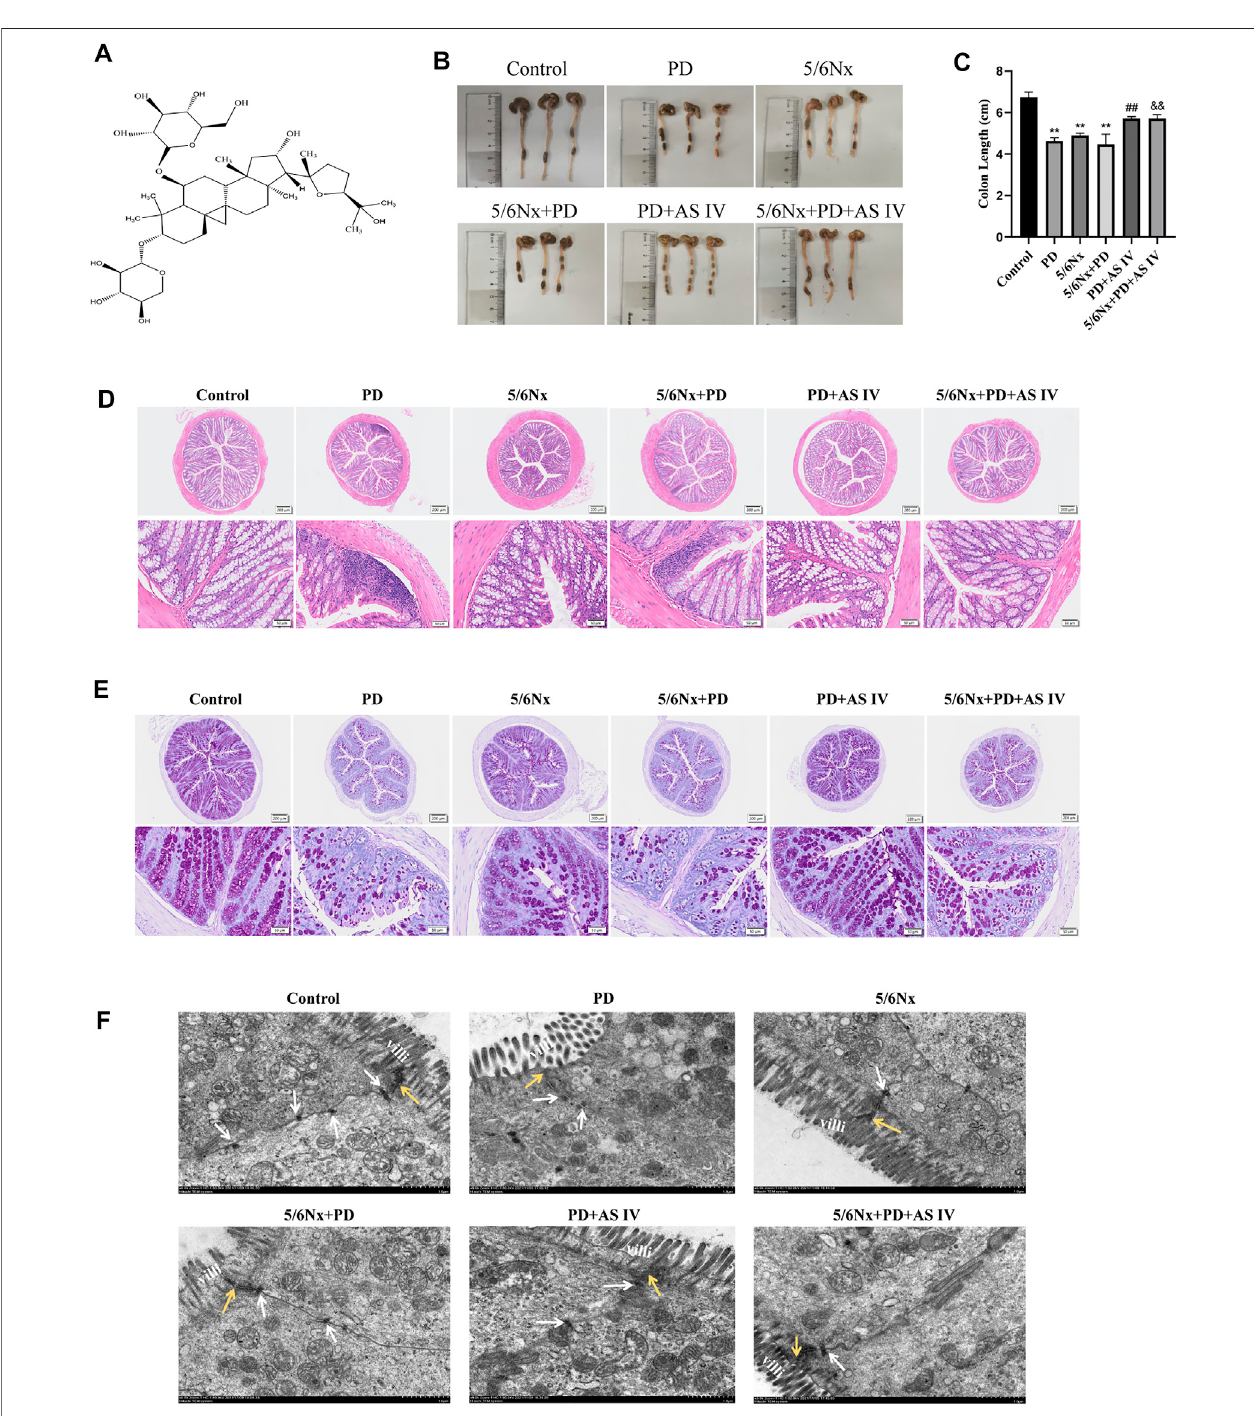
FIGURE 1 | Effects of AS IV on the integrity of the intestinal mucosal epithelium in mice exposed to peritoneal dialysis fl uid (PDF) (A) Chemical structure of AS IV (B,C) Lengthofthecolon (D) Representativehematoxylinandeosin(H&E)stainingofcolonicsections, showingtheappearanceoftheintestinalmucous membranes (E) Representative periodic acid-Schiff (PAS) stainingof colonic sections, indicatinggoblet cell morphologyand quantity (F) Ultrastructure ofcolonic mucosa observed with a transmission electron microscope. Yellow arrow, tight junction protein; white arrow, desmosomes; villi, microvilli (Scale bar = 1 μ M). Data are presented as means ± SD of three independent experiments. * p < 0.05 or ** p < 0.01 versus the control group. # p < 0.05 or ## p < 0.01 versus the PD group. & p < 0.05 or && p < 0.01 versus the 5/6Nx + PD group.